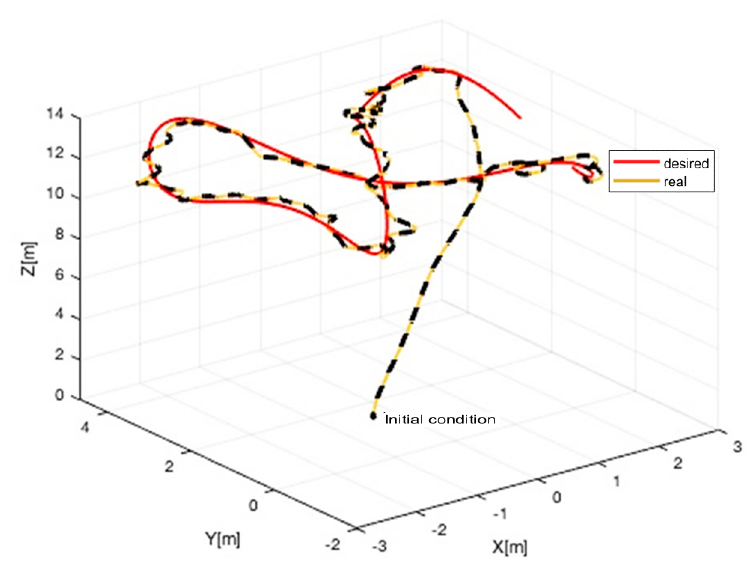
Figure 14. Trajectory tracking: LAMDA controller.